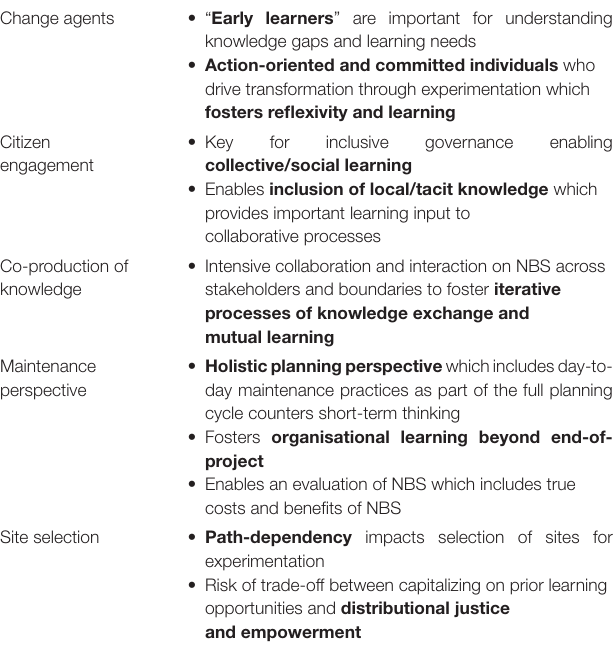
TABLE 1 | Seeds of transformative learning in the two cases of NBS implementation. Change